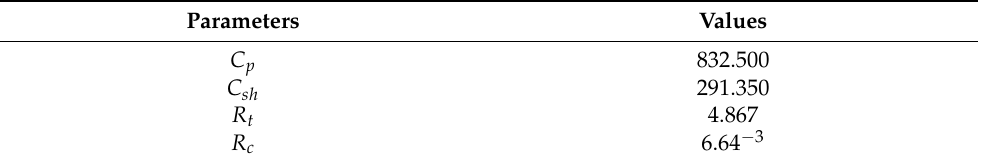
Table 5. Parameters used in the lumped